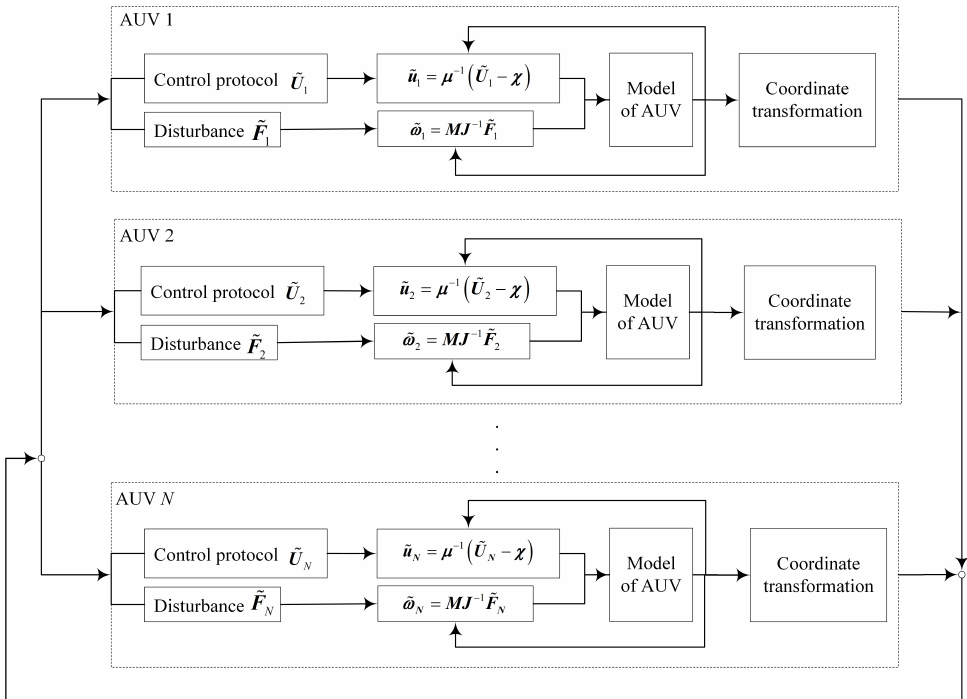
Figure 2. The formation control scheme of a multi-AUV